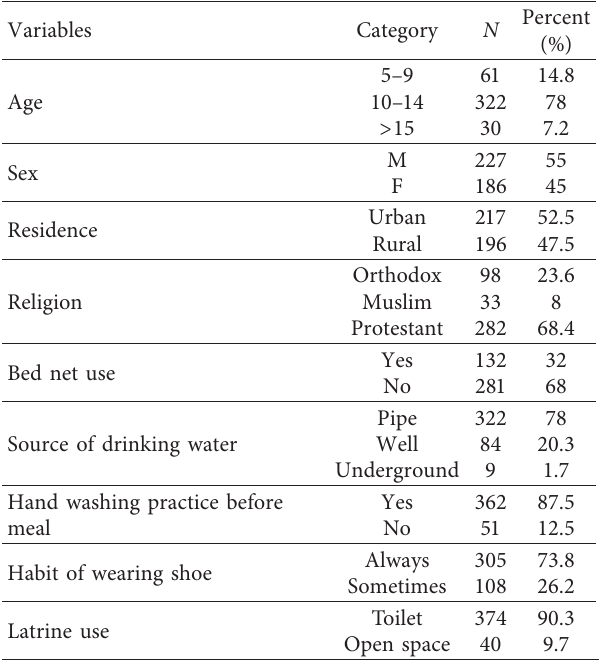
Table 1: Sociodemographic characteristics of primary school children in Gedeo zone,